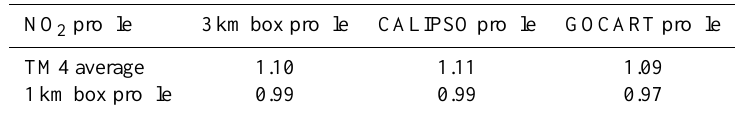
Table 5. Summertime aerosol correction factors, defined as the ratio of the air mass factor with and without aerosols (fine particles, SSA=0.97), calculated with the SCIATRAN radiative transfer model for a typical summertime scenario over the eastern United States. The AOT was 0.5 (at 440 nm), and the solar zenith angle 30 ◦ . The aerosol vertical profiles refer to a constant extinction from the surface up to 3km, and to average observed (CALIPSO) and simulated (GOCART) profiles over the eastern United States (see Yu et al., 2010). The assumed NO 2 profiles refer to the TM4 average shown in Fig. 13 (lower panel) for situations when MODIS AOT > 0.2, and a profile with the same verically integrated NO 2 amount, but now confined to a 1-km boundary layer.